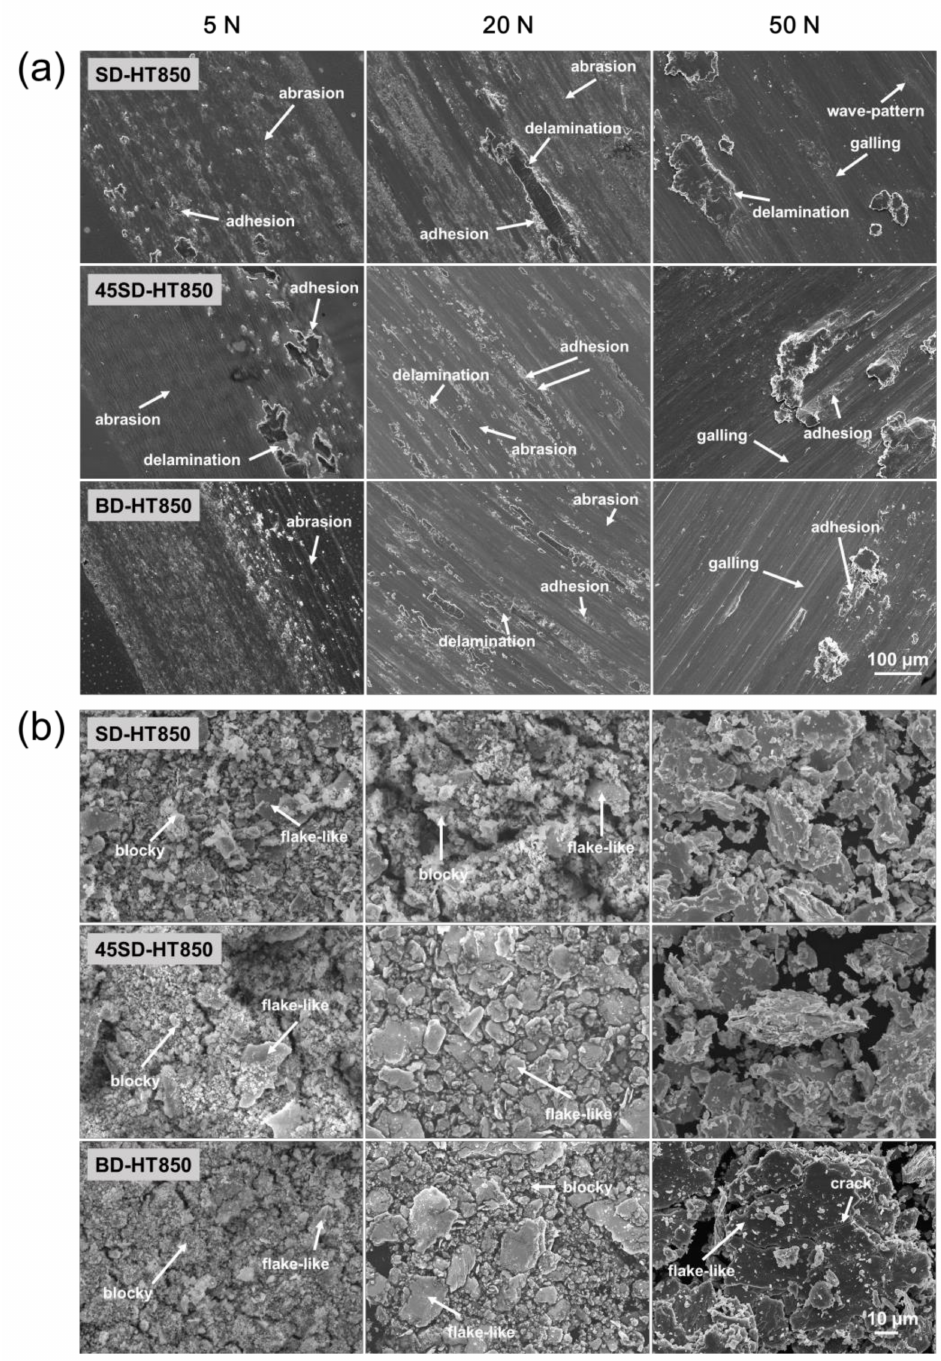
Figure 5. SEM images of ( a ) worn surface and ( b ) wear debris of HT-850 samples worn against AISI 52100 steel ball with different wear